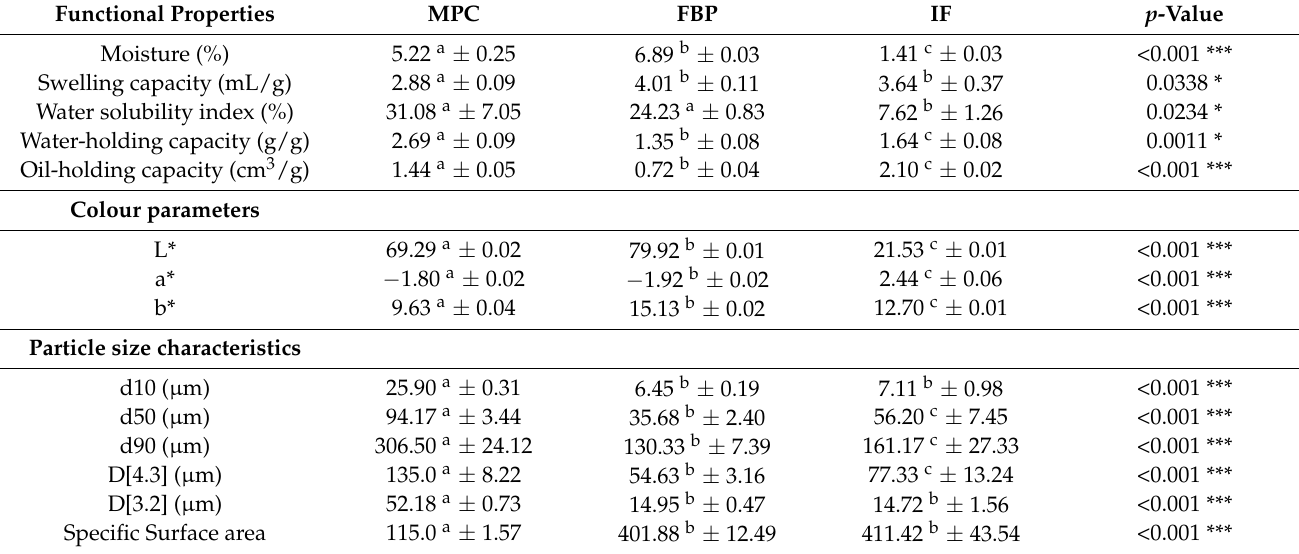
Table 2. Physicochemical characteristics of milk protein concentrate (MPC), faba bean protein concentrate (FBP) and insect flour (IF). The entries show means ± standard deviations, n =